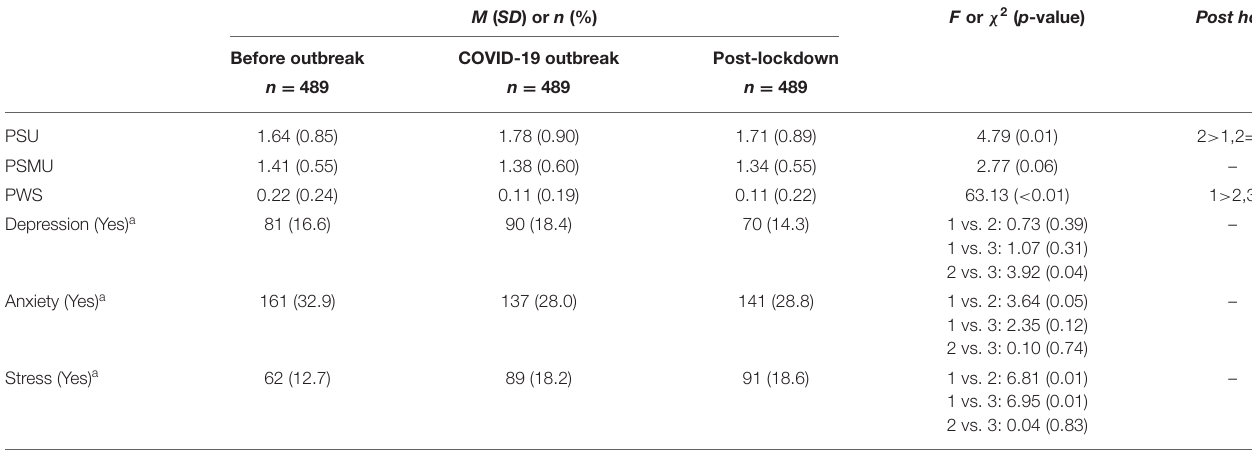
TABLE 2 | Comparisons of problematic internet-related use, perceived weight stigma, fear of COVID-19, and psychological distress across time.